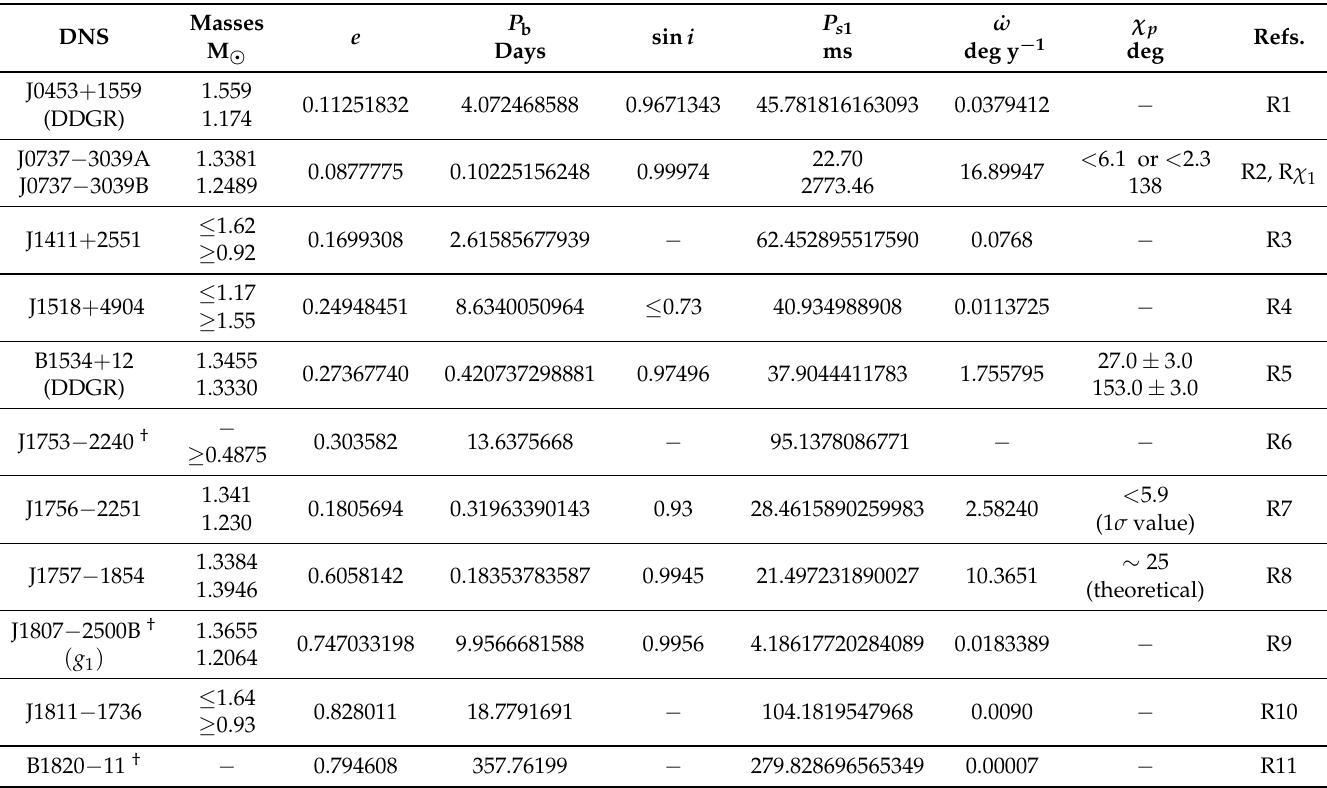
Table 1. Relevant observed parameters for known pulsars in DNSs. See the references for these parameters with more significant digits and uncertainties. The timing model (e.g., DDGR) is mentioned when more than one timing solution is available in the original